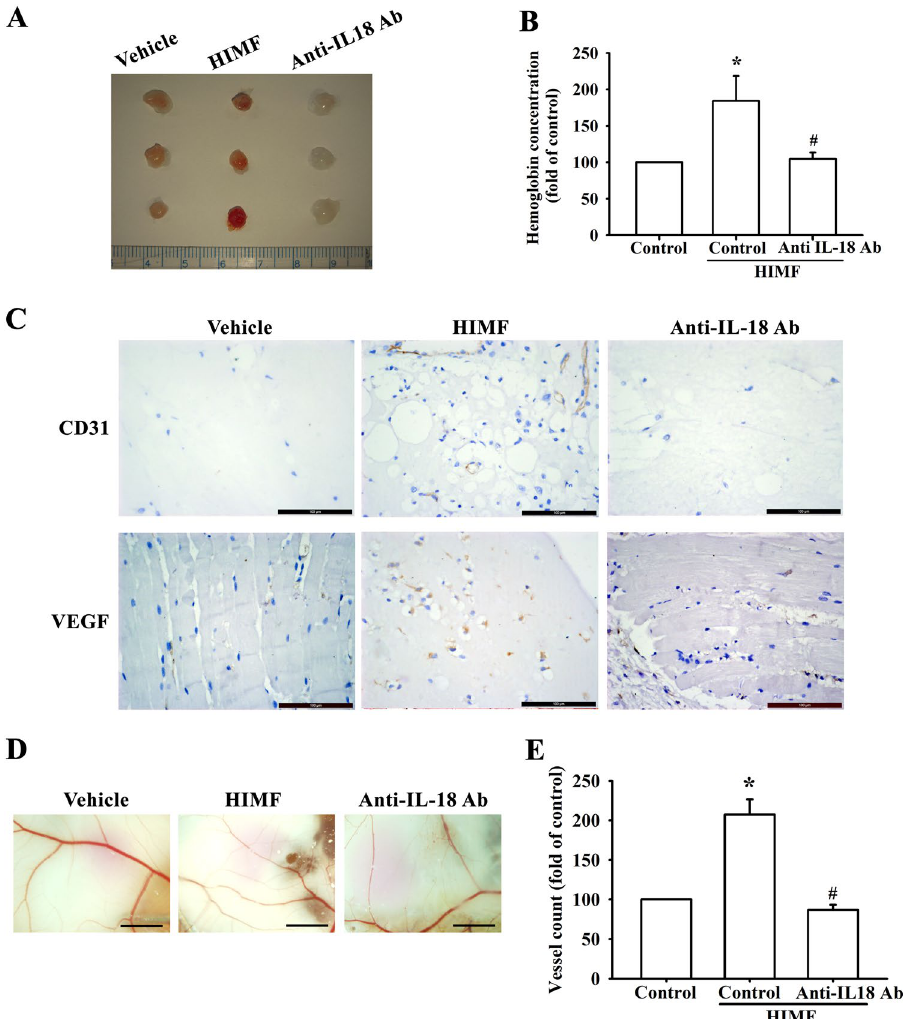
Figure 6. HIMF promotes VEGF expression and angiogenesis in vivo . ( A ) Matrigel plugs containing myoblast conditioned medium (CM) of PBS (vehicle), HIMF (10 nM), or anti-IL-18 antibody combined with HIMF were subcutaneously injected into the flanks of nude mice. After 7 days, the plugs were photographed. ( B ) Hemoglobin levels from the plugs were quantified and normalized to control group. ( C ) Specimens from the plugs were immunostained with antibodies against CD31 and VEGF. Scale bar: 100 μ m. ( D ) Data from a CAM assay using 5-day-old fertilized chick embryos (6 eggs/group): PBS (vehicle), CM with HIMF (10 nM) treatment, or CM with anti-IL-18 antibody followed by HIMF treatment were resuspended in Matrigel and placed onto the CAMs, which were allowed to develop for another 3 days. The CAMs were then examined by microscopy and photographed. Scale bar: 2 mm. ( E ) CAM vessels were calculated and quantified. Results are expressed as the means ± SEM of four independent experiments. * p < 0.05 as compared with the control group. #p < 0.05 as compared with HIMF-treated